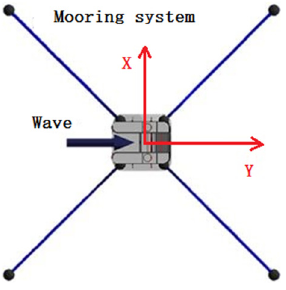
Figure 3. A schematic diagram of the catenary mooring method.